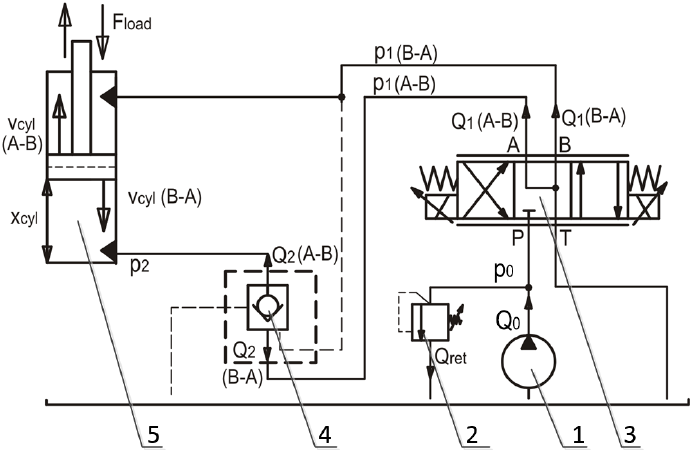
Figure 2. Scheme of hydraulic system: 1—pump, 2—relief valve, 3—control valve, 4—check valve, 5—actuator; (A-B), (B-A)—flow